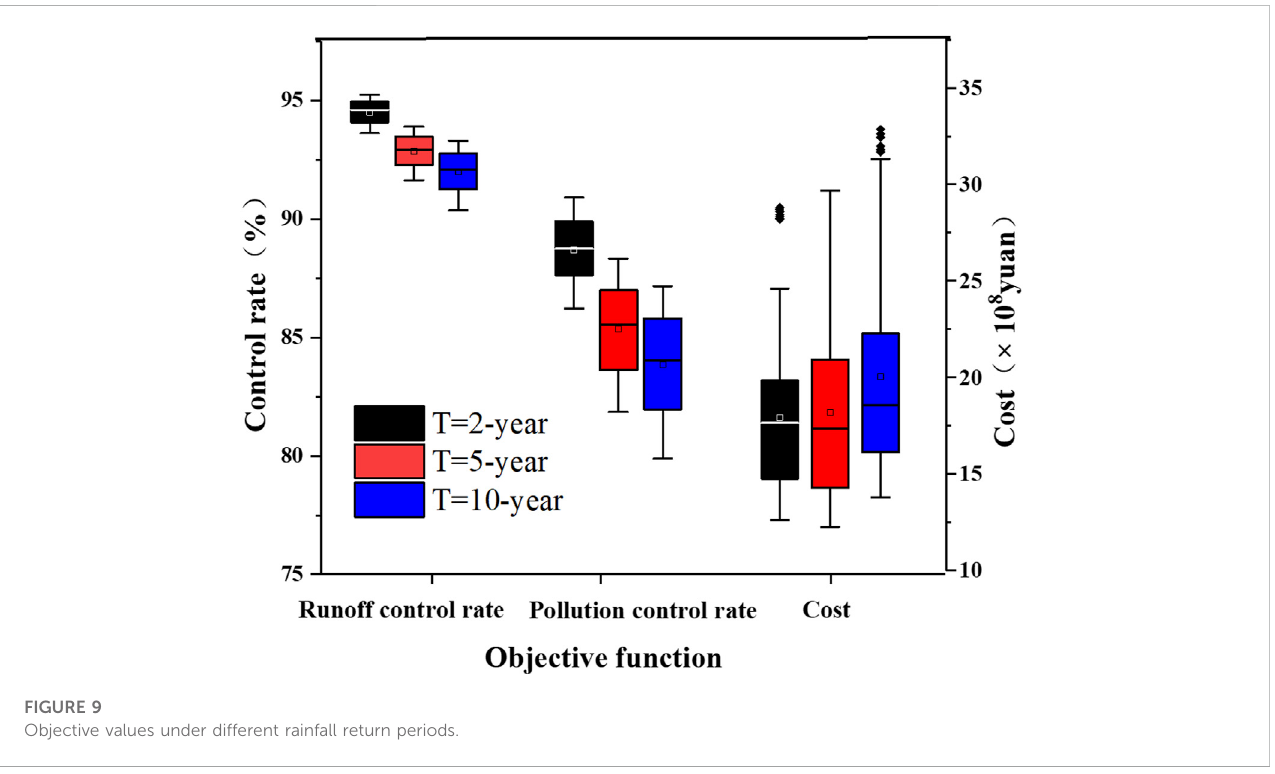
FIGURE 9 Objective values under different rainfall return periods.